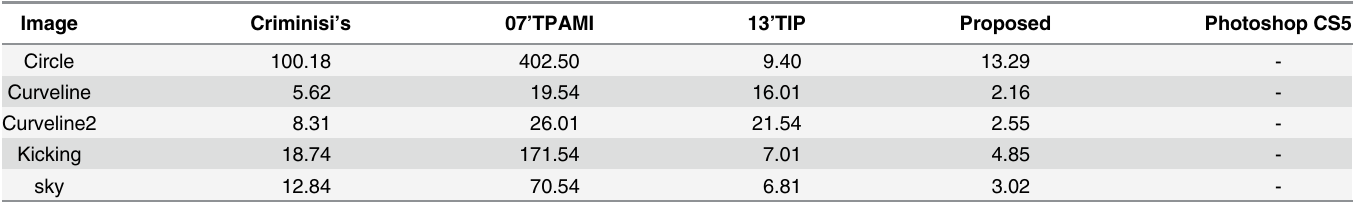
Table 2. Computation time of different methods: Criminisi ’ s [23], “ 07 ’ TPAMI ” [18], Photoshop CS5 [16], “ 13 ’ TIP ” [19] and the proposed method. Note that we can not measure the time of Photoshop CS5 accurately, but it is the fastest method. (Time unit: second.) Image Criminisi ’ s Proposed Photoshop CS5 Circle Curveline